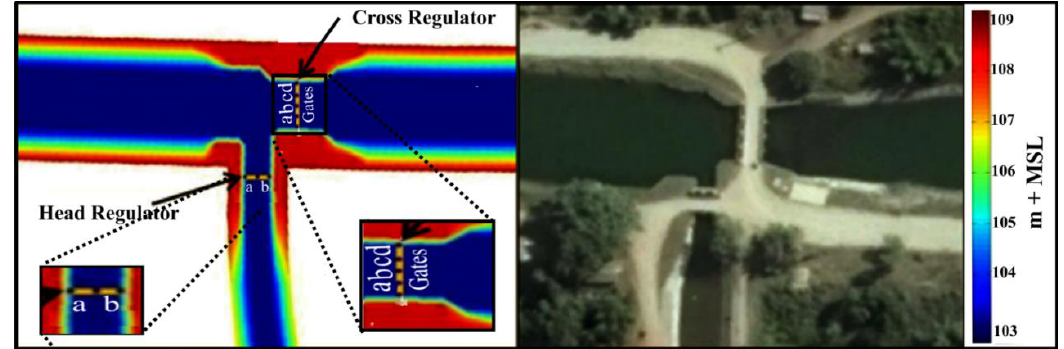
Figure 7. The location of Gates in the Canals in the model ( left ) and as seen in Google Earth ( right ).